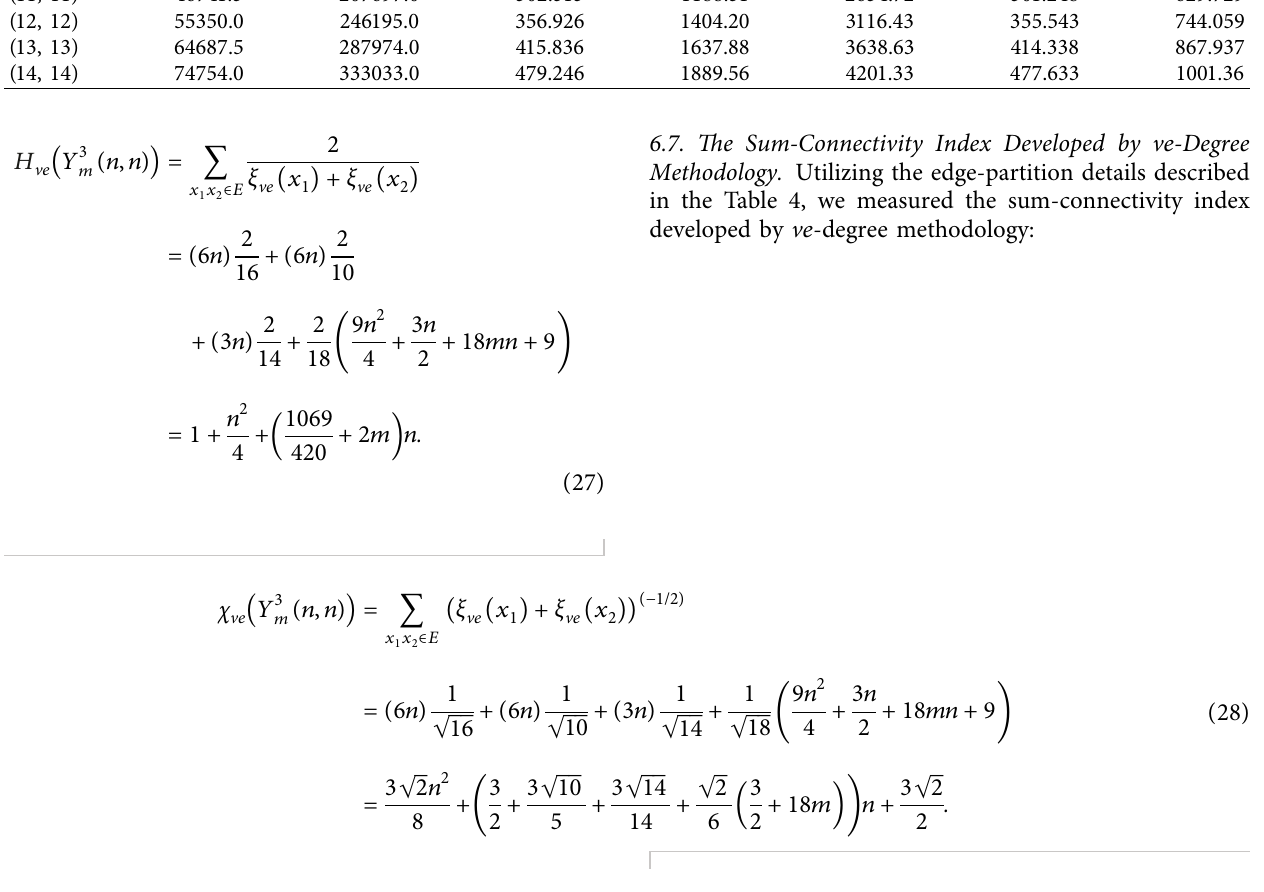
, M 2 ve , H ve , R ve , χ ve , ABC ve , GA ve for Y -junction graph Y 3 m ( n, n ) β ve